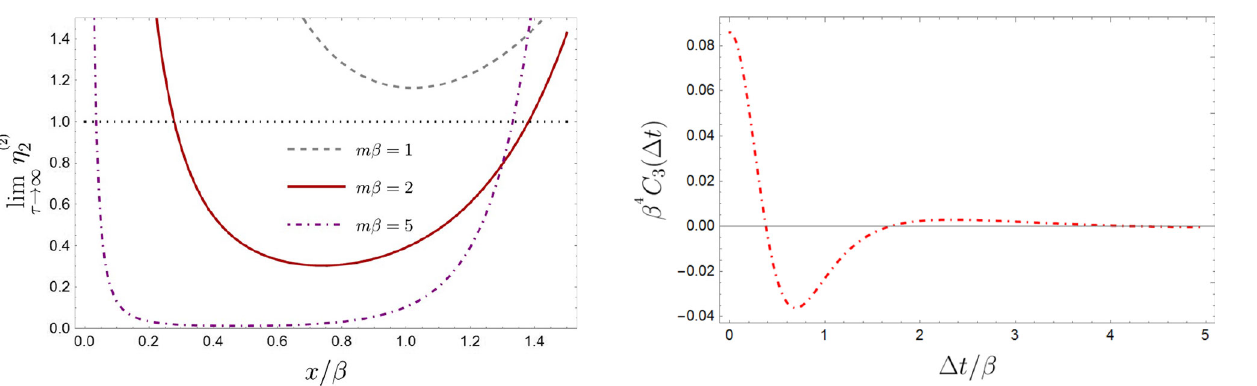
Fig. 9 Distance behavior of the vacuum versus thermal dominance for different values of m β . Here we set D = 2 and τ s /β = 1. In this case we always have thermal dominance sufficiently near the wall. However, vacuum dominance occurs in certain regions, depending on the value of the field mass